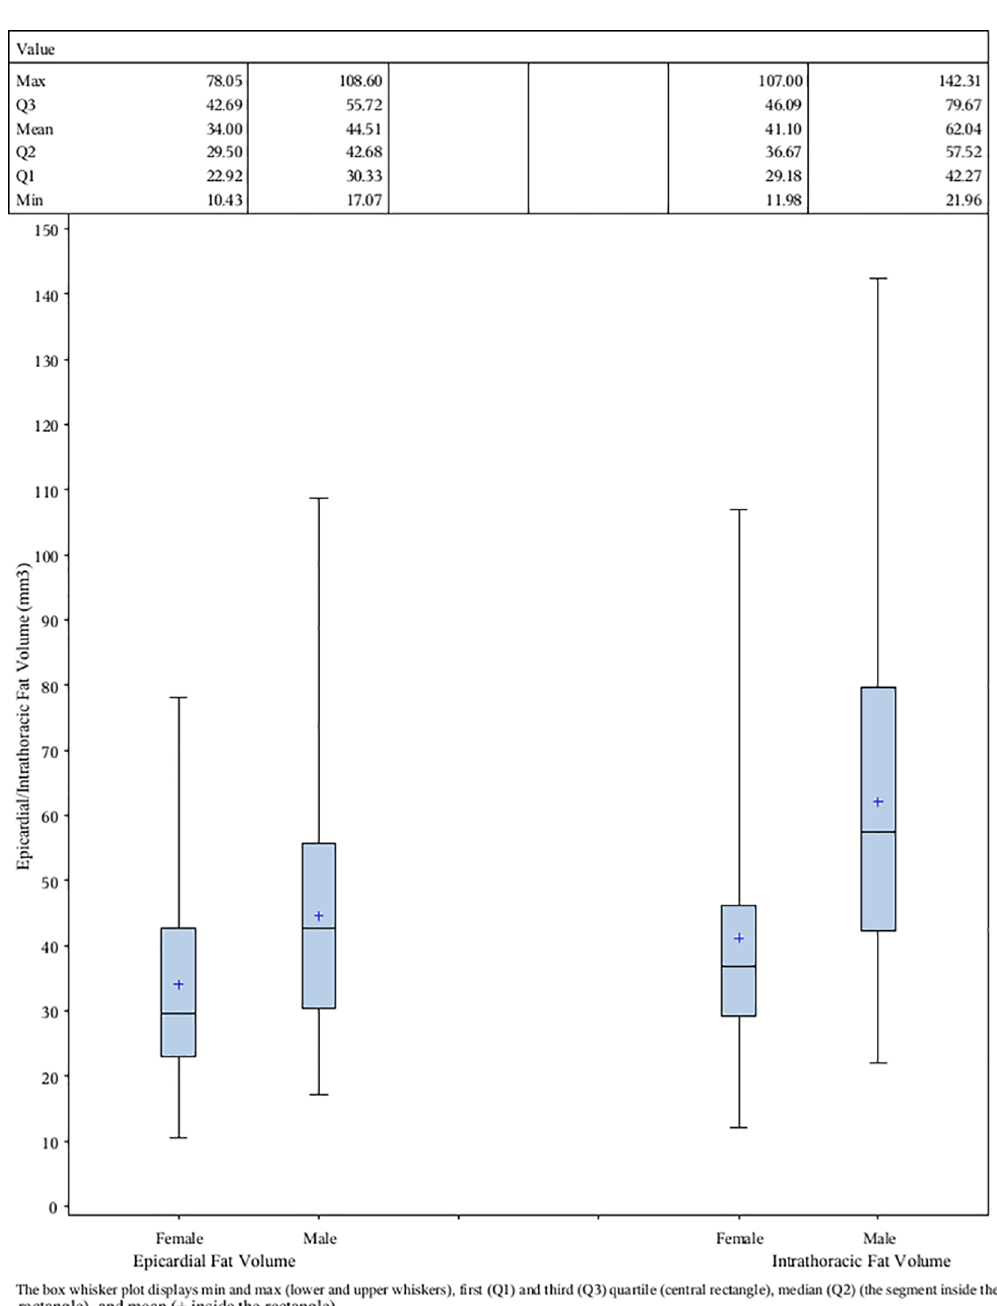
Fig 2. Epicardial/Intrathoracic Fat Volume with Sample Weight Adjustment by Gender. The box whisker plot displays min and max (lower and upper whiskers), first (Q1) and third (Q3) quartile (central rectangle), median (the segment inside the rectangle), and mean ( (cid:3) /+ inside the